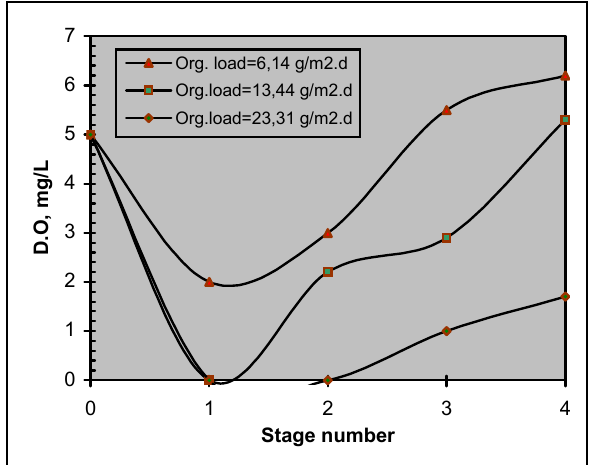
Figure 15: Effect of organic loading on the dissolved oxygen concentration in the RBC stages (rotational velocity = 10rpm).